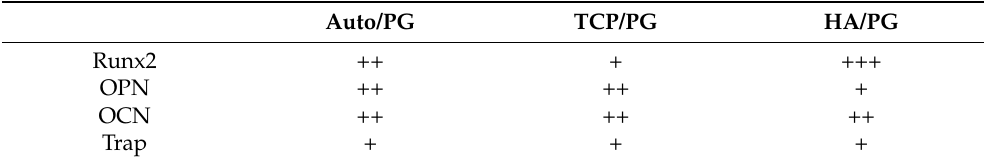
Figure 8. Representative photomicrographs of immunolabeling against Runx2, osteopontin, osteocal- cin, and Trap antibodies in the Auto/PG group at 30 days of critical defect repair. ( A ): Runx2 20 × magnification; ( B ): OPN 20 × magnification; ( C ): OCN 20 × magnification; ( D ): Trap 20 × magnifi- cation; ( E ): Runx2 40 × magnification; ( F ): OPN 40 × magnification; ( G ): OCN 40 × magnification; ( H ): Trap 40 × magnification; Counter-staining: Harris Hematoxylin; Red arrows: immunolabeling cells (represent positive labeling for each protein evaluated in the regions of interest). Scale bar: 100 µ m (20 × magnification) and, 50 µ m (40 × magnification). Table 1. Immunolabeling scores in Auto/PG, TCP/PG, and HA/PG at 30 days of bone repair. Antibodies against Runx2, OPN, OCN, and